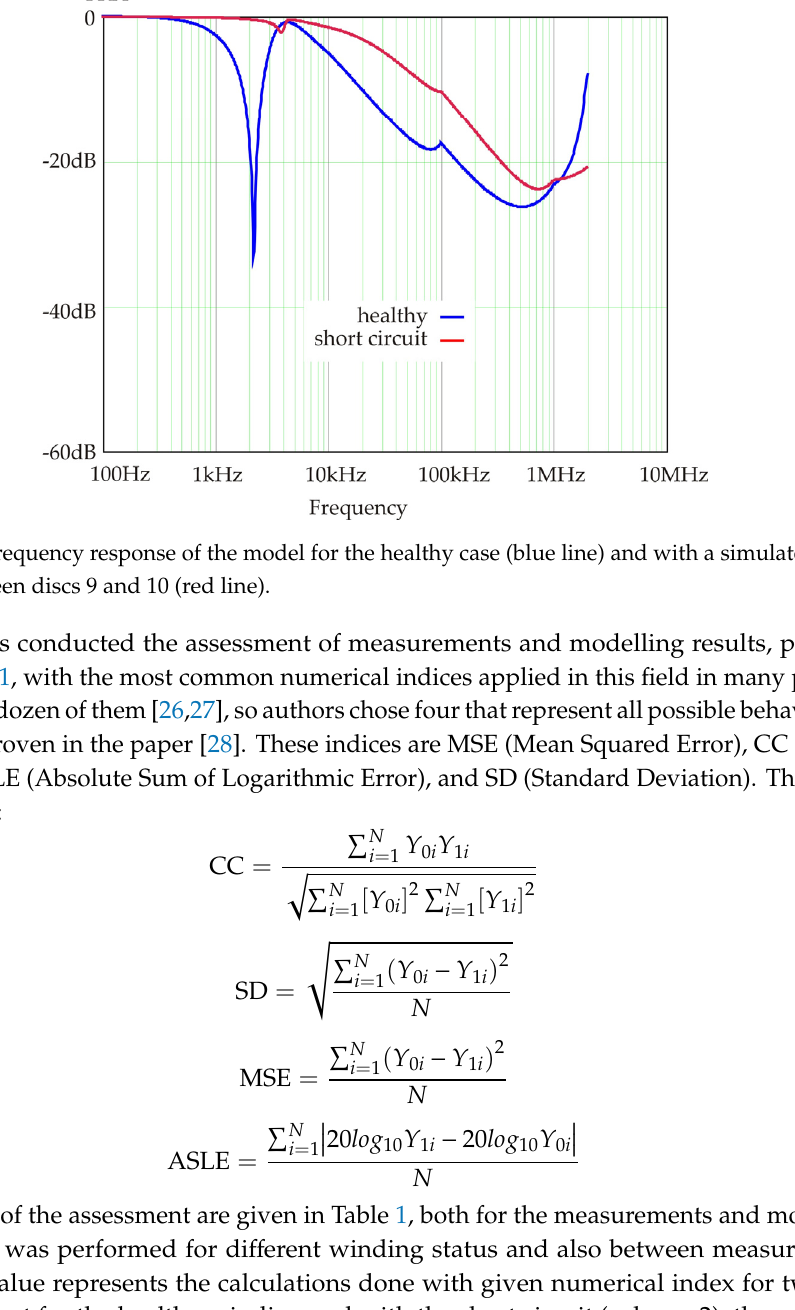
Table 1. Results of the assessment with CC, SD, MSE, and ASLE indices.